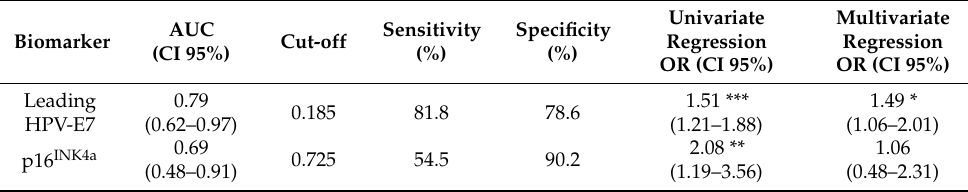
Table 6. ROC analysis and univariate and multivariate logistic regression for